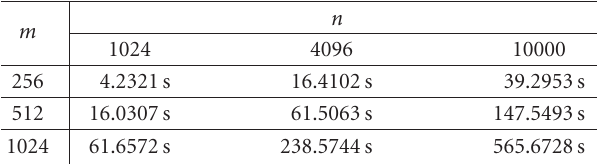
Table 1: Computation time for 60